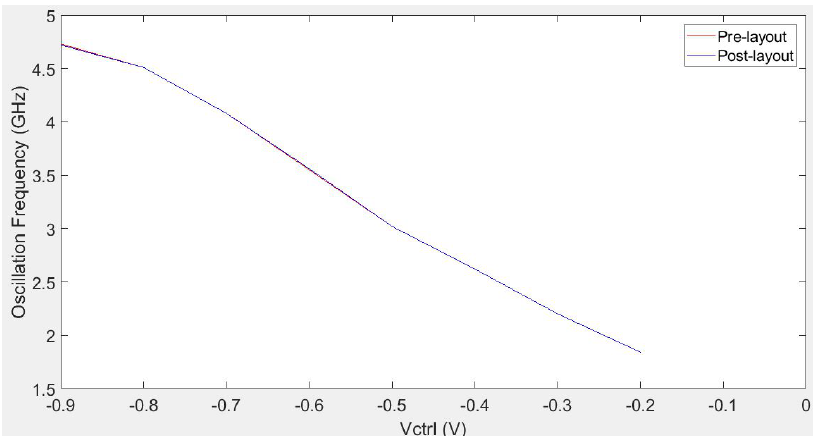
Figure 18. Comparison of the oscillation frequency vs. control voltage for the pre- and post-layout simulations of the VCO.